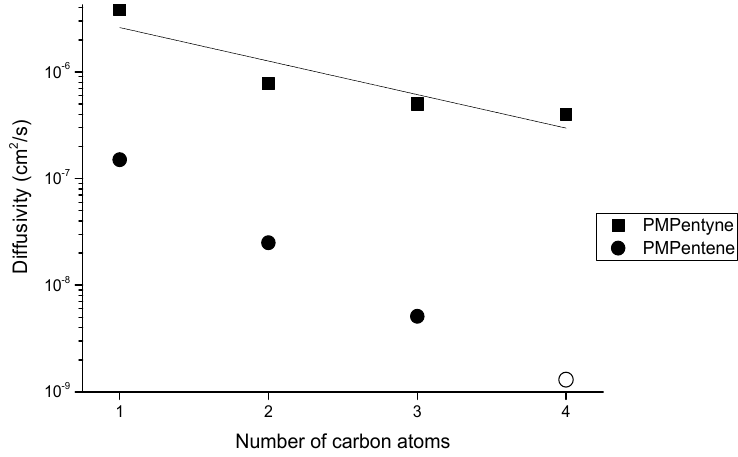
Figure 4. Permeability coefficients of PMPentyne and PMPentene at 10 °C: , experimental data; , data calculated using correlation approach (Equations (7)–(9)).